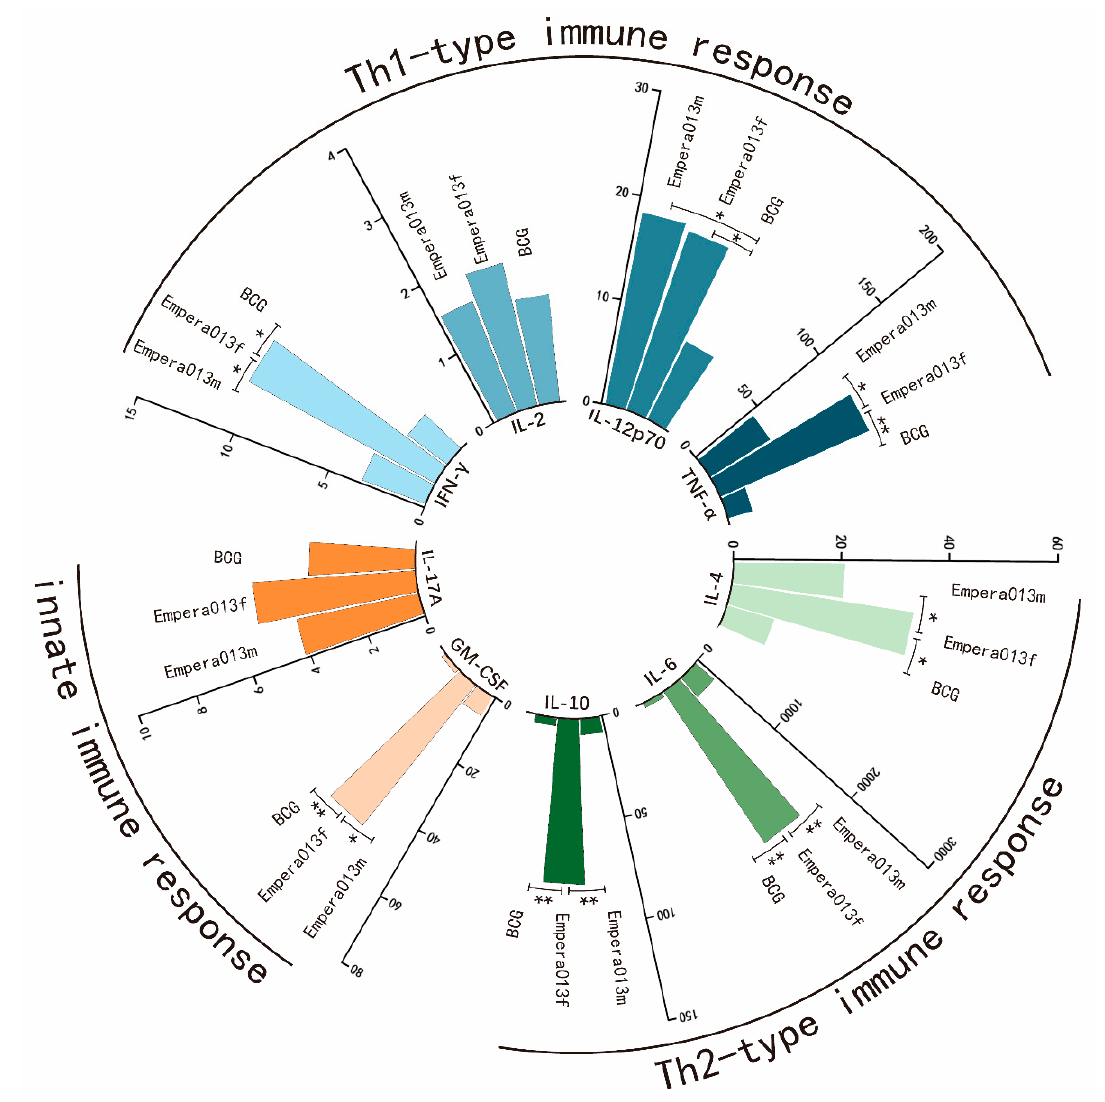
Figure 6. Antigen-specific cytokine secretion levels of murine splenocytes stimulated with corre- sponding antigens or BCG antigens ( n = 6 for each group, mean values ± S.E.M.). IL-2, IL-4, IL-6, IL- 10, IL-12p70, IL-17A, IFN- γ , TNF- α and GM-CSF were measured using Luminex multiplex